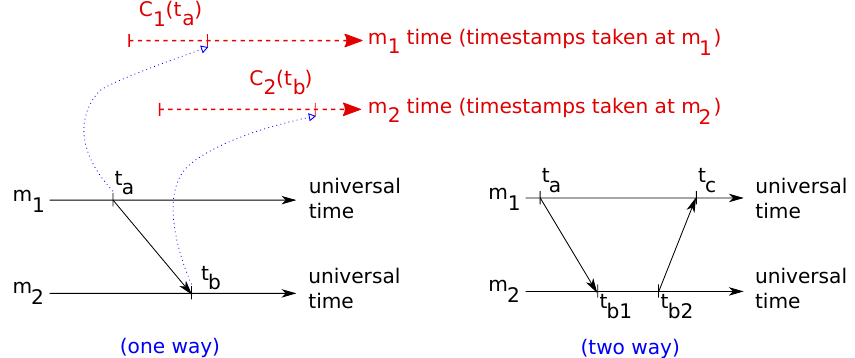
Figure 1. The most common message exchange schemes for clock synchronization: ( left ) one-way, ( right ) two-way. Note that the local time of each device ( top ) can start at any point in the universal time line and tick at any